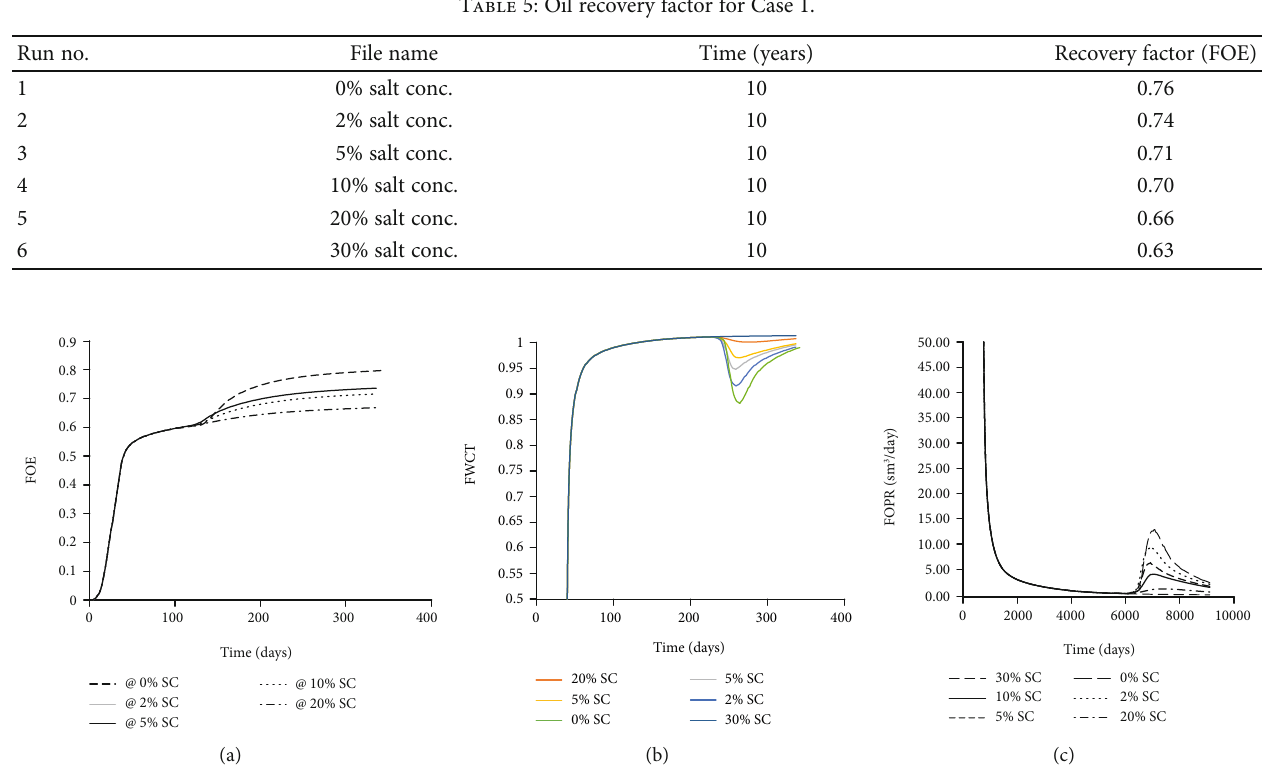
Figure 2: (a) Oil recovery. (b) Water cut. (c) Oil production